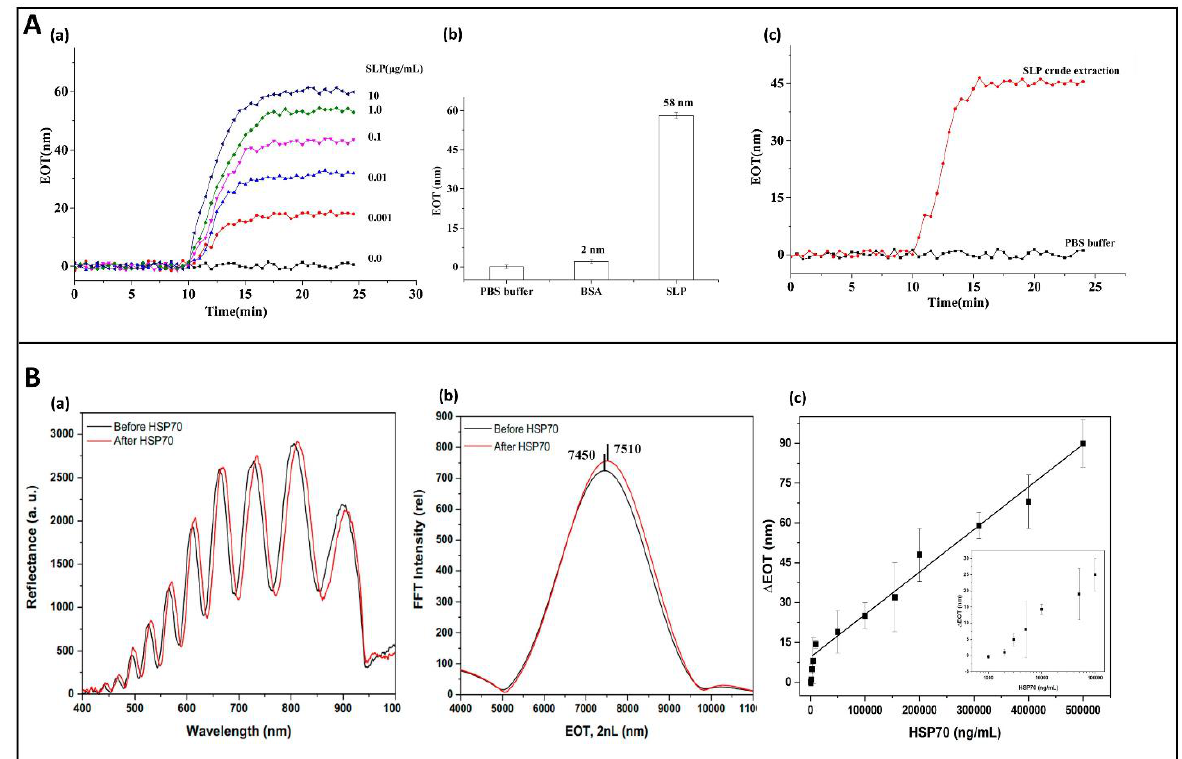
Figure 4. ( A ) (a) EOT signals of anti-SLP/ProteinA/TiO 2 -PSi-based immunosensor after incubation in different SLP concentrations (from bottom to up). (b) Specificity test of TiO 2 -PSi-microfluidic biosensor measured via EOT response to BSA and SLP. (c) SLP detection in a dilute crude extract. Reprinted with permission from Reference [80]; Copyright (2020) Elsevier B.V. ( B ) (a) Reflectivity spectra and (b) corresponding Fourier Transforms (FFT) of anti-HSP70-PSi device before (black line) and after (red line) HSP70 detection at concentration of 200,000 ng/mL. (c) Relationship between HSP70 concentrations and EOT shifts (inset semi-log plot). Reprinted with permission from Reference [83]; Copyright (2020) Elsevier Ltd.